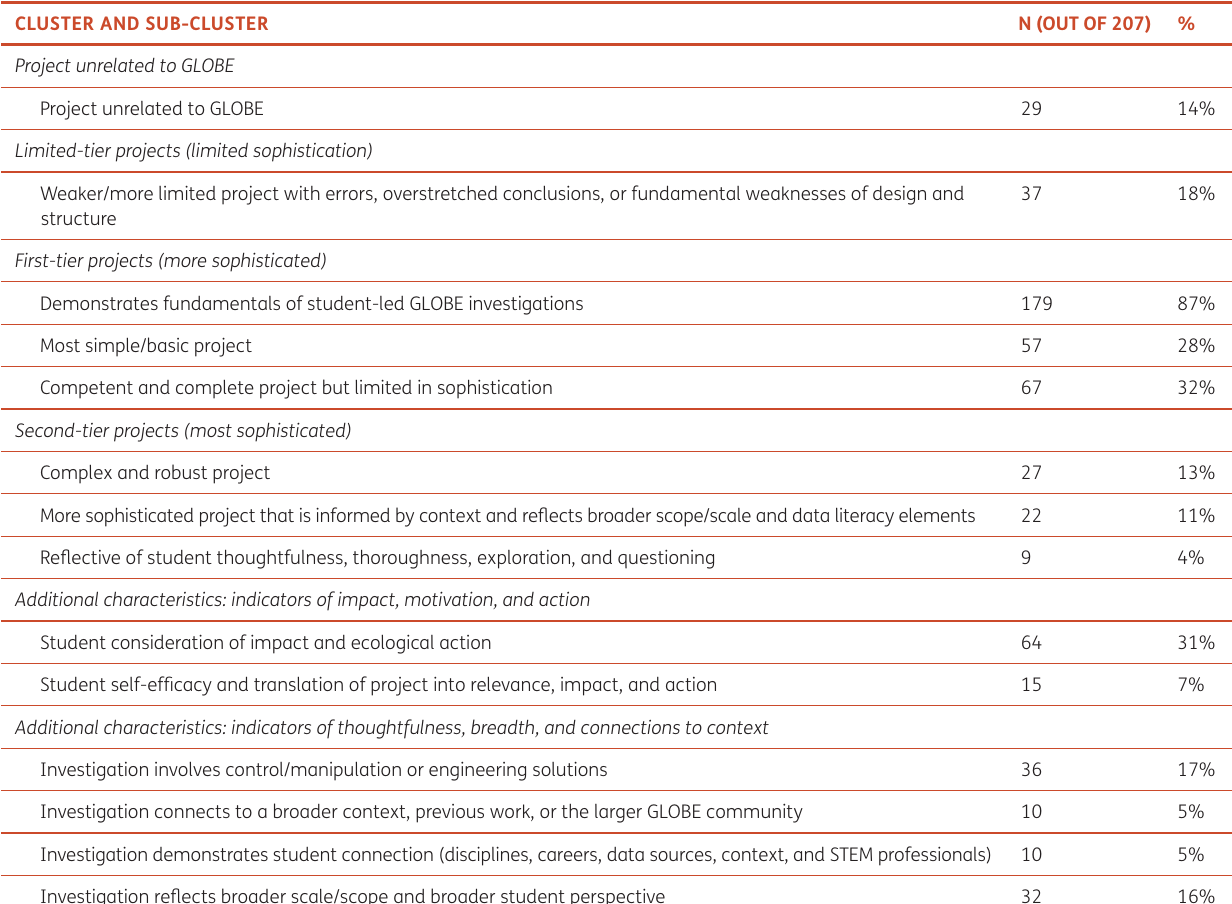
Table 4 Frequency of project alignment with identified clusters and